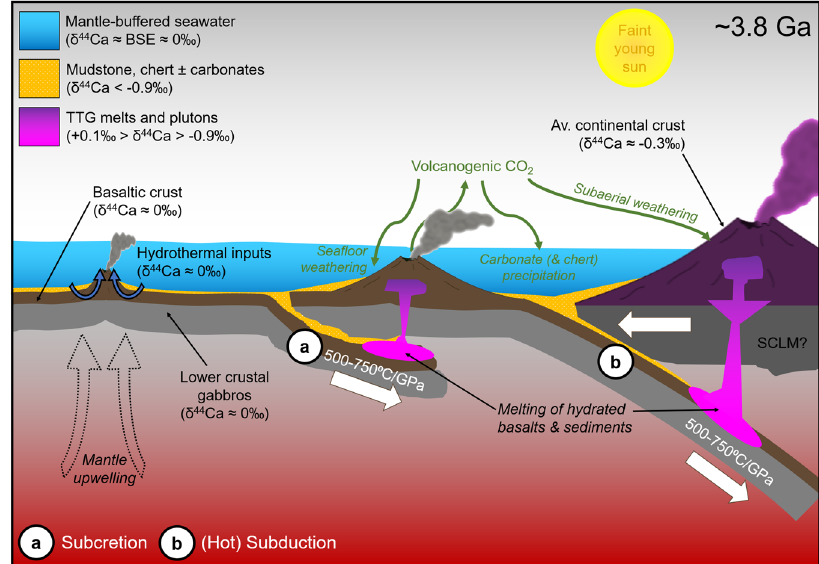
Fig. 4 Schematic diagram of geodynamic settings supported by our TTG data [e.g. subcretion (a), localized roll-back (not shown) 7 , and/or modern- style subduction (b)]. Apparent geothermal gradients (500 – 750 °C/GPa) are similar to those reported for modern adakites 5,6 and hot